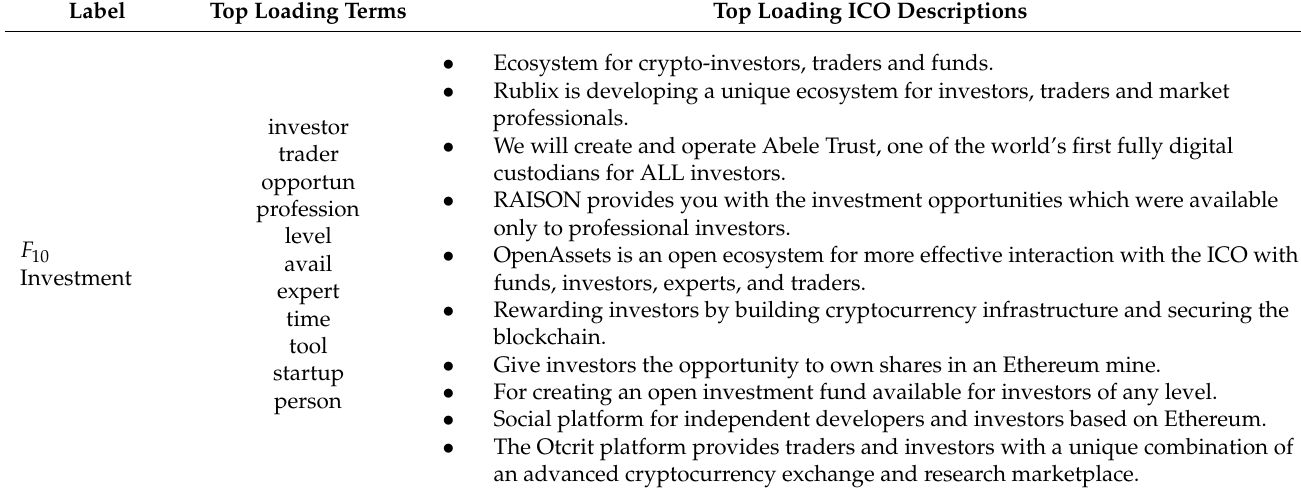
Table A10. Investment.